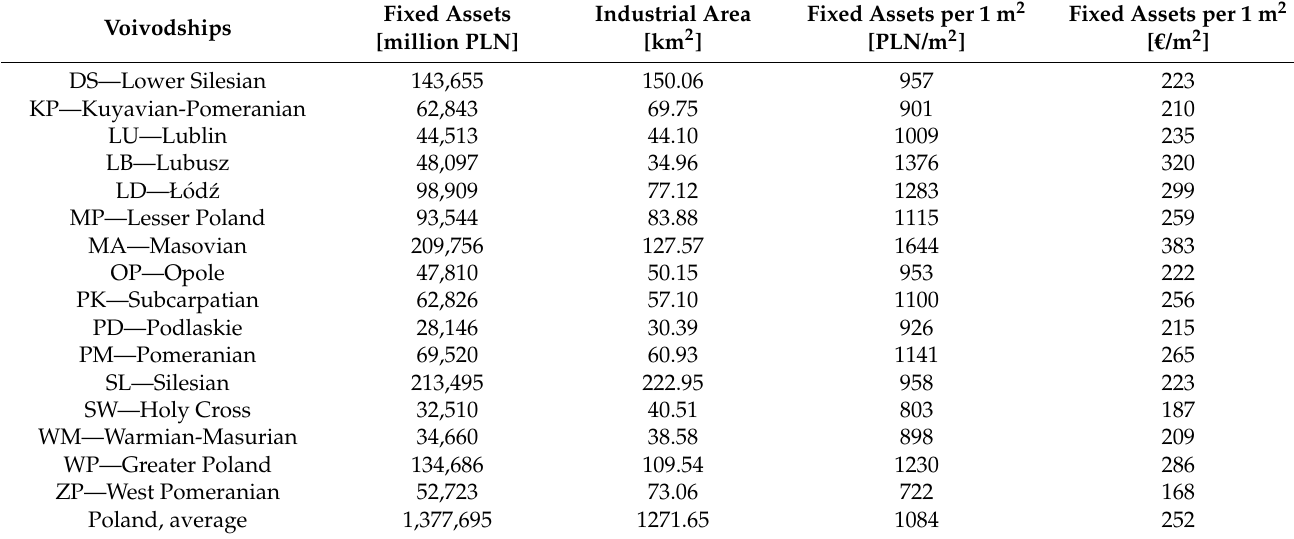
Table 7. Value of fixed assets in industrial areas in 16 voivodships (in 2019 prices).